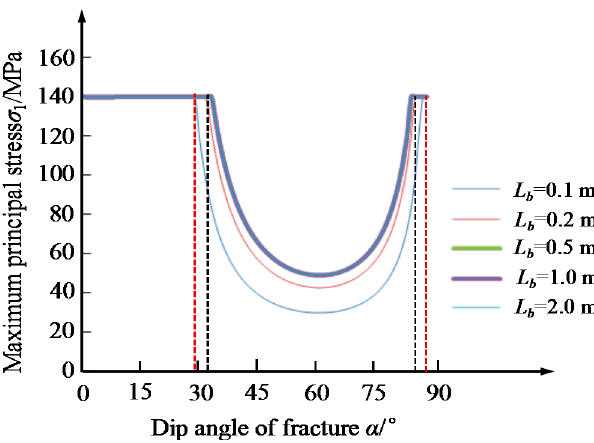
Figure 8. Effect of different anchorage lengths on rock strength.